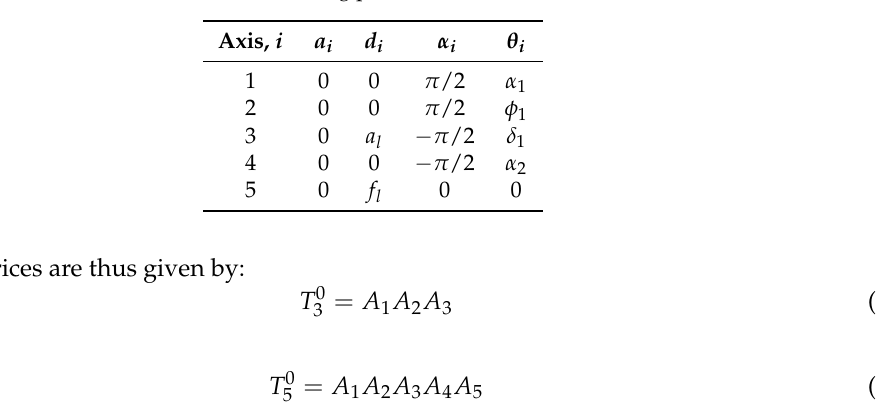
Table A1. Denavit–Hartenberg parameters of the kinematic